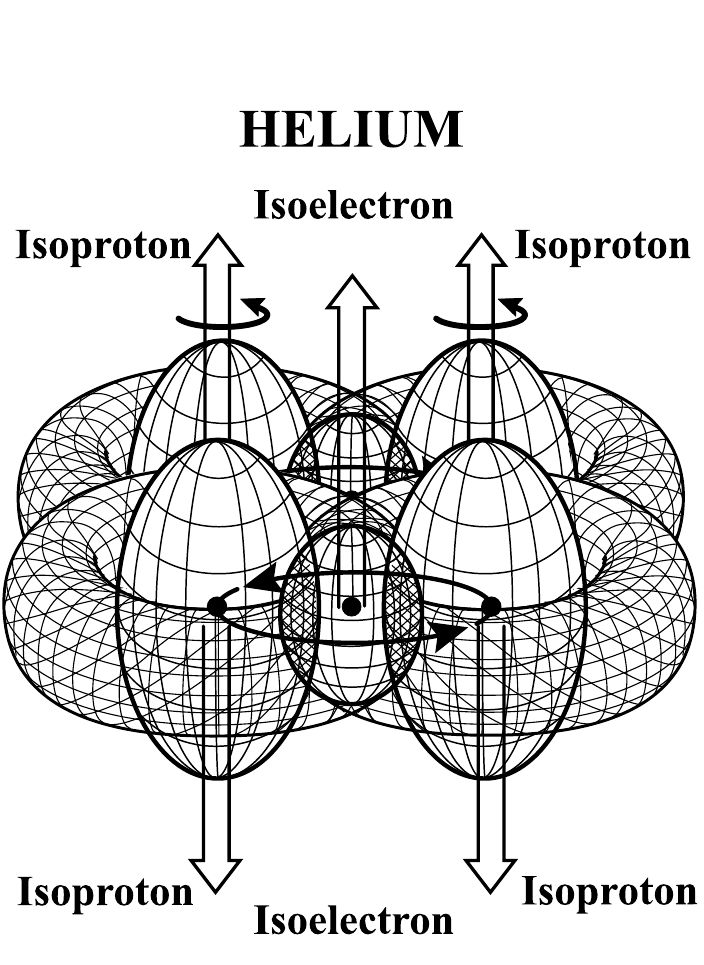
Figure 18: An illustration of the helium nucleus as predicted by hadronic mechanics and consisting of four isoprotons and two isoelectrons. Note that the illustration depicts the conventional conception of the Helium as being composed by two protons and two neu- trons, with the sole replacement of the neutrons with their physical constituents permitted by hadronic mechanics, the proton and the electron. Note finally that the uncertainties of the constituents of the helium follow Einstein’s determinism per Lemma II-3.7 and Corol- lary